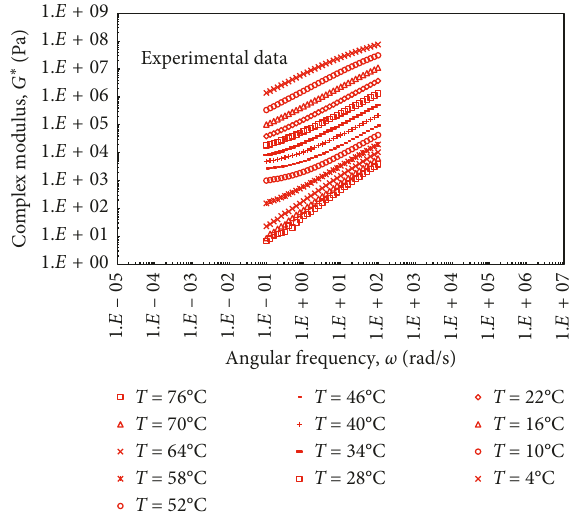
Figure 14: Phase angle master curve ( δ vs. ω